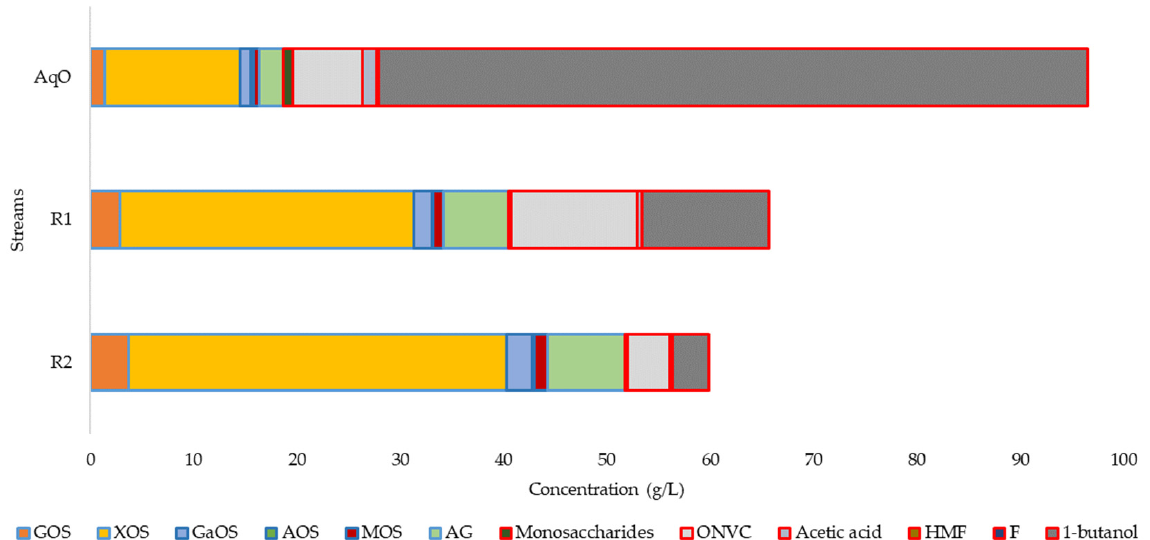
Figure 5. Composition of the aqueous streams (AqO, R1 and R2) involved in the membrane processing. Nomenclature: GOS, glucose units in oligosaccharides (OS); XOS, xylose units in OS; GaOS, galactose units in OS; AOS, arabinose units in OS; MOS, mannose units in OS; AG, acetyl groups linked to OS; HMF, hydroxymethylfurfural; F, furfural; ONVC, other non-volatile compounds.